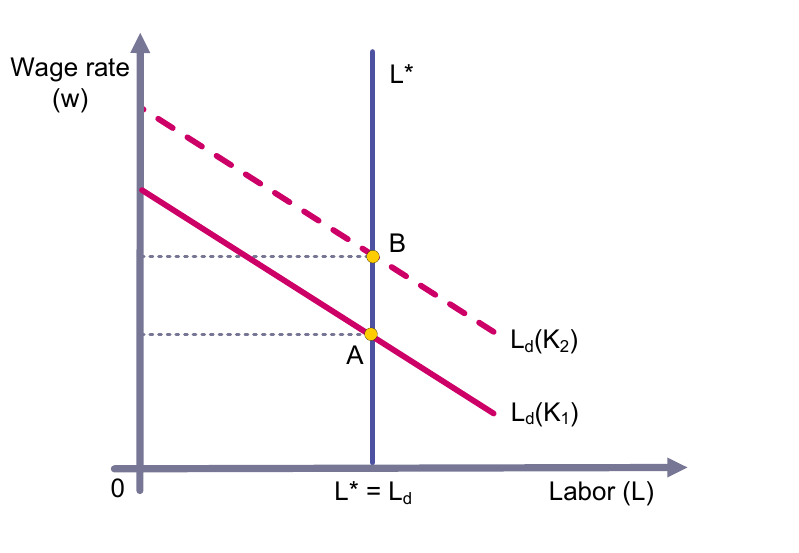
Figure 2. The labor